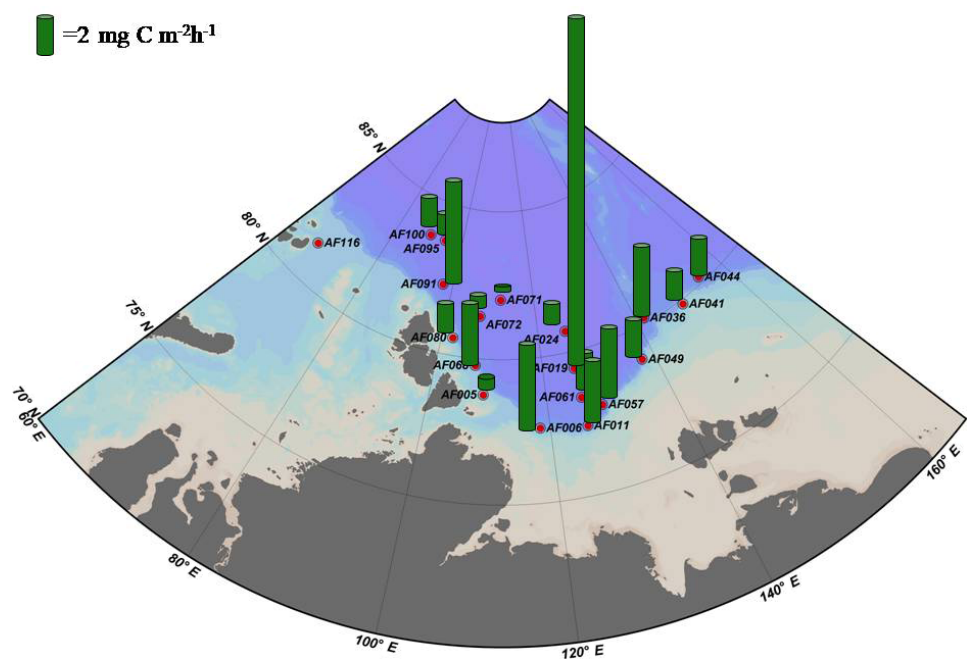
Figure 3. The depth-integrated small phytoplankton C uptake rates in the sampling